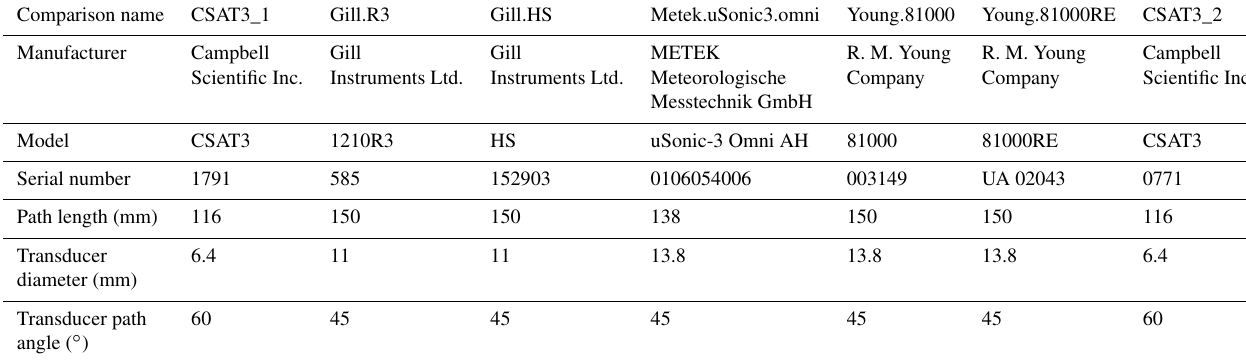
Table 1. Participating instruments in the order of their location from east to west.